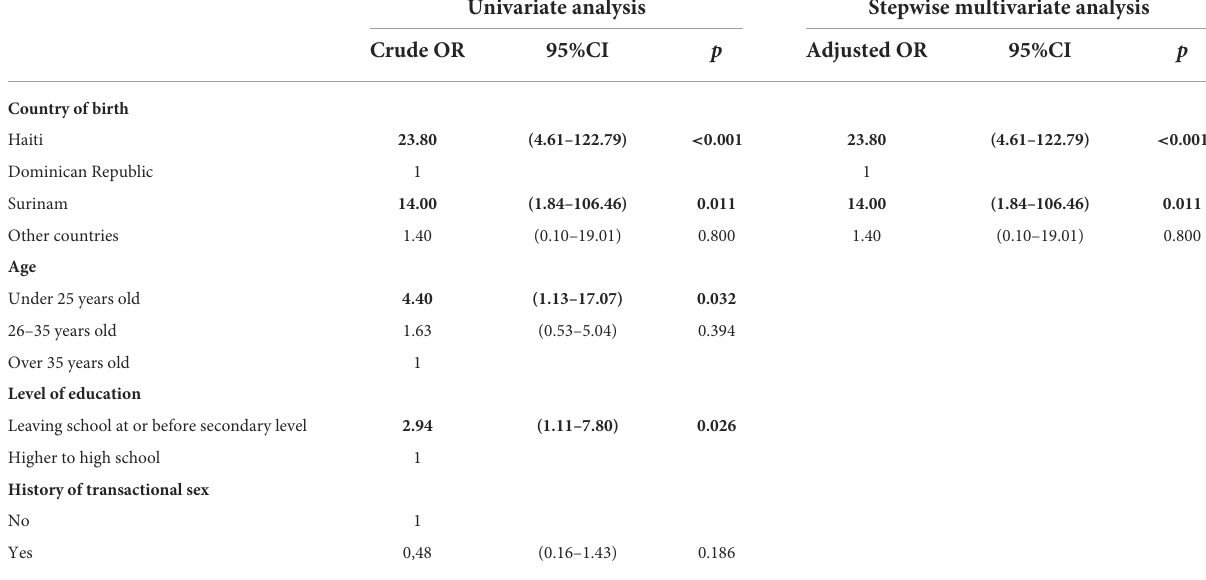
TABLE 2 Univariate and multivariate analyses of factors associated with unprotected sexual intercourse with casual partners among migrant women attending Red Cross HPCs in 2021 using stepwise downward logistic regression ( n = 75) AUC = 0.78. Univariate analysis Stepwise multivariate